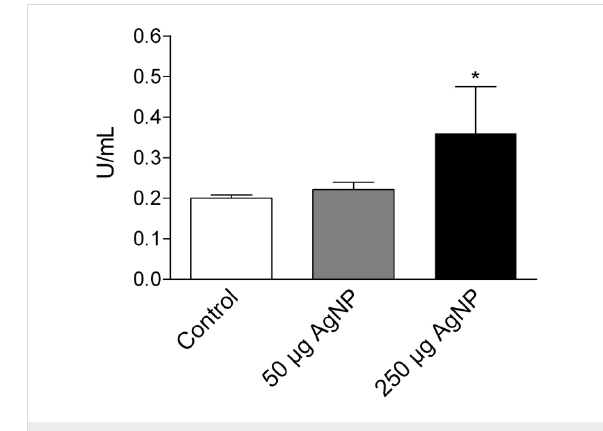
Figure 4: LDH levels in BALF 24 hours after intratracheal instillation of PVP-AgNP. Values are mean ± SEM; n = 5 for each treatment group; *p < 0.05 vs control.